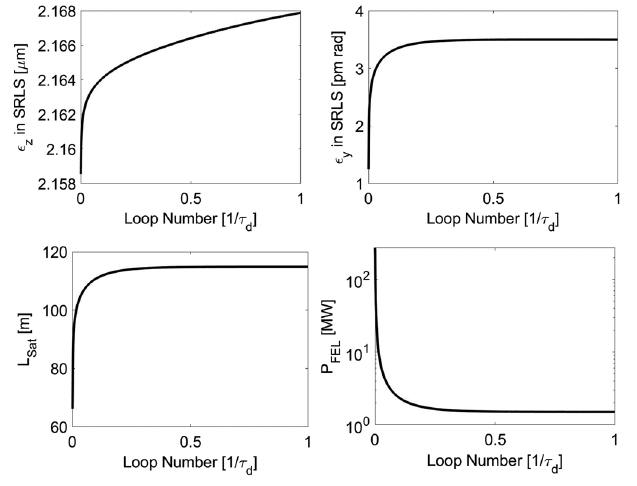
FIG. 7. From top-left to bottom-right: Electron beam longi- tudinal emittance and geometric vertical emittance in the SRLS, FEL saturation length and peak power out of an 80 m-long TGU, vs number of loops in units of longitudinal damping time. The FEL wavelength is 4 nm. The same bunch is lasing every 2.5 turns in the SRLS (227